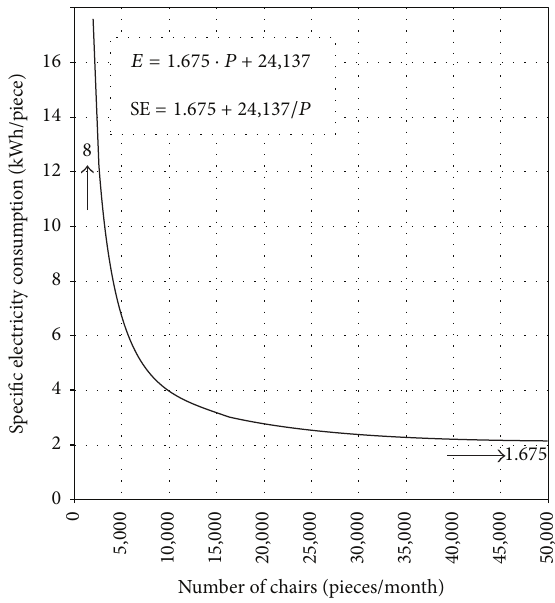
Figure 4: Dependence of specific energy consumption on produc- tion